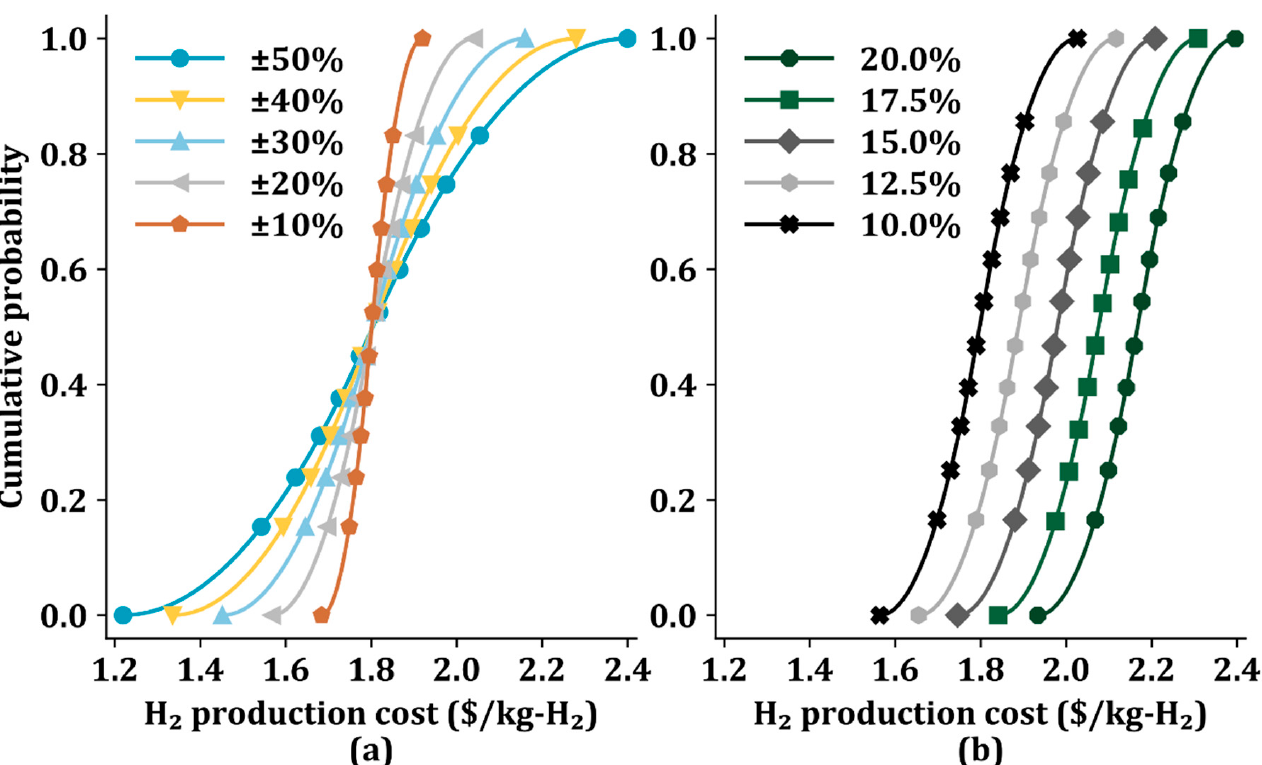
Figure 6. Cumulative probability of H 2 production cost in Sc 6 using the Monte Carlo method with ( a ) different influential economic parameters from ± 10% to ± 50% and a fixed internal rate of return of 10%, and ( b ) different internal rates of return from 10.0% to 20.0% and two key parameters (feedstock cost and CO 2 capture cost) of ±20%.